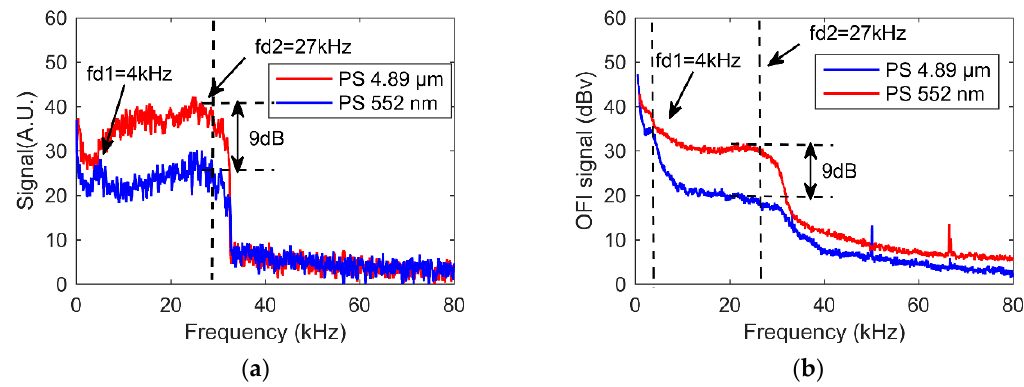
Figure 5. Optical feedback interferometry (OFI) signal frequency spectra obtained with PS particles of 552 nm diameter (red), 4.89 µm (blue): ( a ) simulated spectra; ( b ) measured spectra.